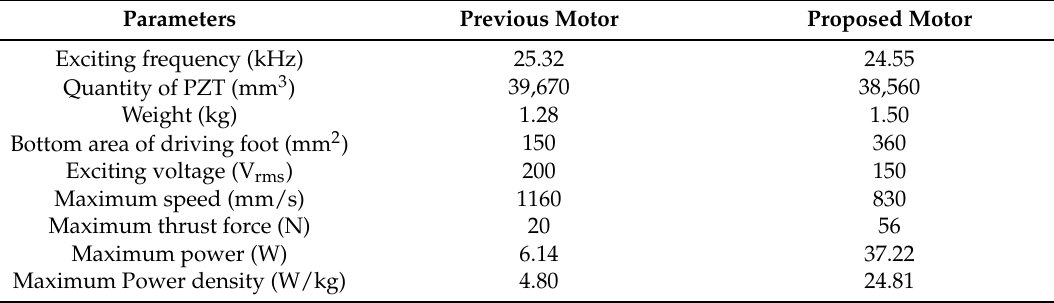
Table 5. Comparison between the proposed motor and the previous